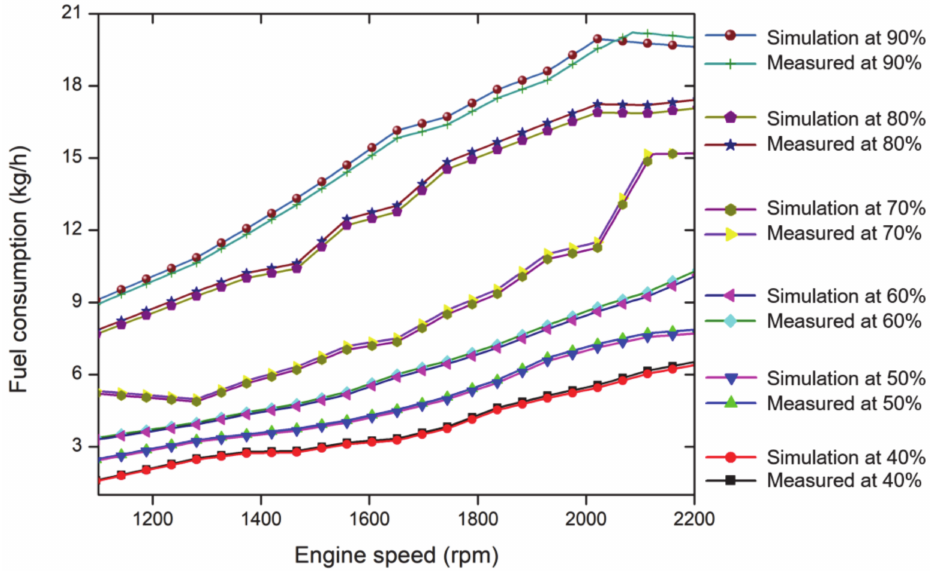
Figure 8. The simulation and measured hourly fuel consumption at various load levels. Table 4. The statistical analysis of both simulation and measured hourly fuel consumptions at various engine load levels.